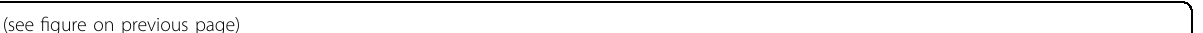
Fig. 4 Exosomes derived from adipose-derived stem cells (ADSCs) decreased endothelial progenitor cell (EPC) senescence under high glucose (HG) conditions. a The apoptosis rate of EPCs was determined by Annexin-V/PI staining after 24 h induction with HG (30 mM) with or without GW4869 (2.5 μ M) pretreatment for 8 h. b The percentage of apoptotic cells was measured, and data are presented as the mean ± SD ( n = 3). *** P < 0.001 vs. HG; ### P < 0.001 vs. HG + ADSCs. c The tube formation capability increased in EPCs stimulated with ADSCs, but the promoted effects decreased after pretreatment with GW4869 (2.5 μ M) for 8 h. d The intracellular ROS levels were determined by immuno fl uorescence using DCH-DA stain. (×200). Scale bar, 20 μ m. e The average fl uorescence intensity of DHE in each group. n = 5, *** P < 0.001 vs. HG; ### P < 0.001 vs. HG + ADSCs. f – k Western blot analysis shows the protein expression levels of SMP30, VEGF, VEGFR2, NOX1, and NOX4. GAPDH served as an internal control. The relative protein level was analyzed, and data are presented as the mean ± SD ( n = 3). *** P < 0.001 vs. HG; ### P < 0.001 vs. HG + ADSCs. l – n In fl ammatory cytokine levels of IL-1 β , IL-6, and TNF- α were measured by ELISA. The relative protein levels were analyzed, and data are presented as the mean ± SD ( n = 3). *** P < 0.001 vs. HG; ### P < 0.001 vs. HG + ADSCs